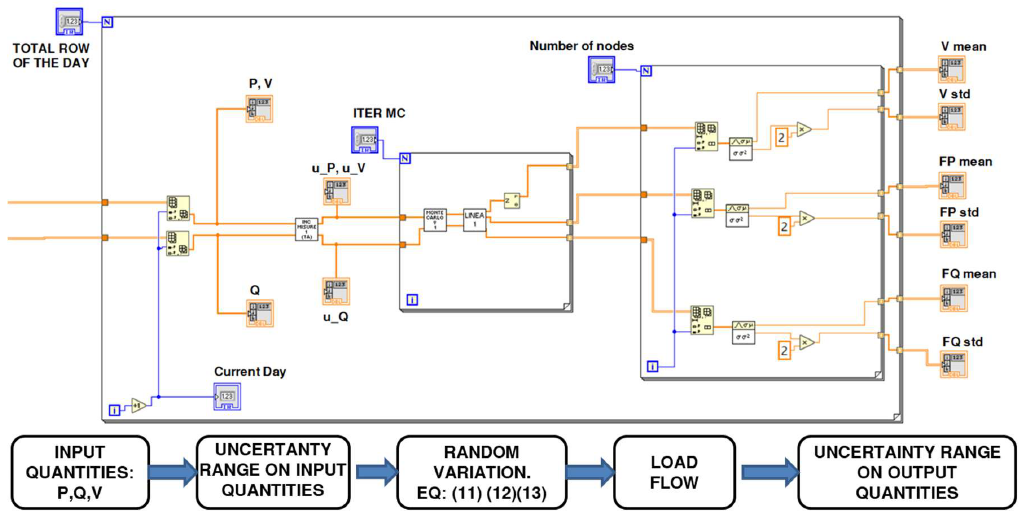
Figure 4. Implementation of the Monte Carlo analysis in LabVIEW.